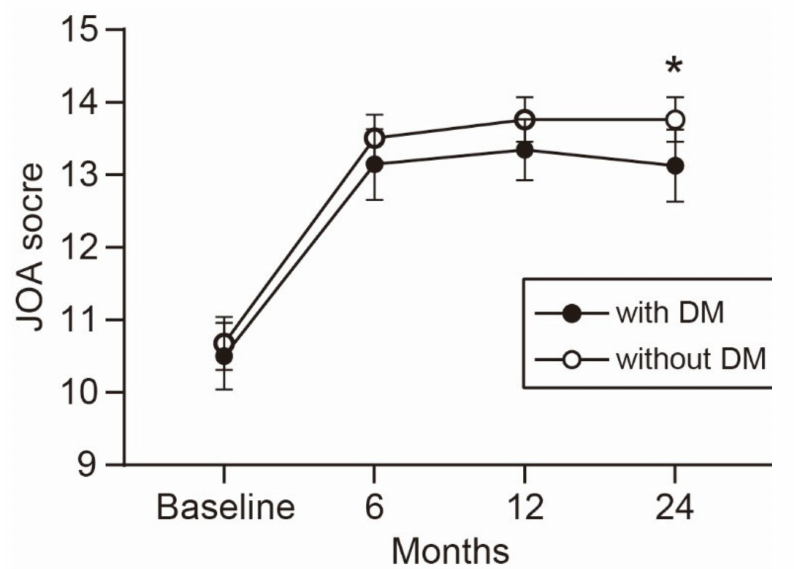
Figure 1. Time-dependent change in the JOA score. The average JOA score was consistently lower in patients with than without DM during the observation period. The difference between the groups increased over time and reached statistical significance at the 2-year follow-up. * p < 0.05, unpaired t -test. JOA, Japanese Orthopedic Association; DM, diabetes